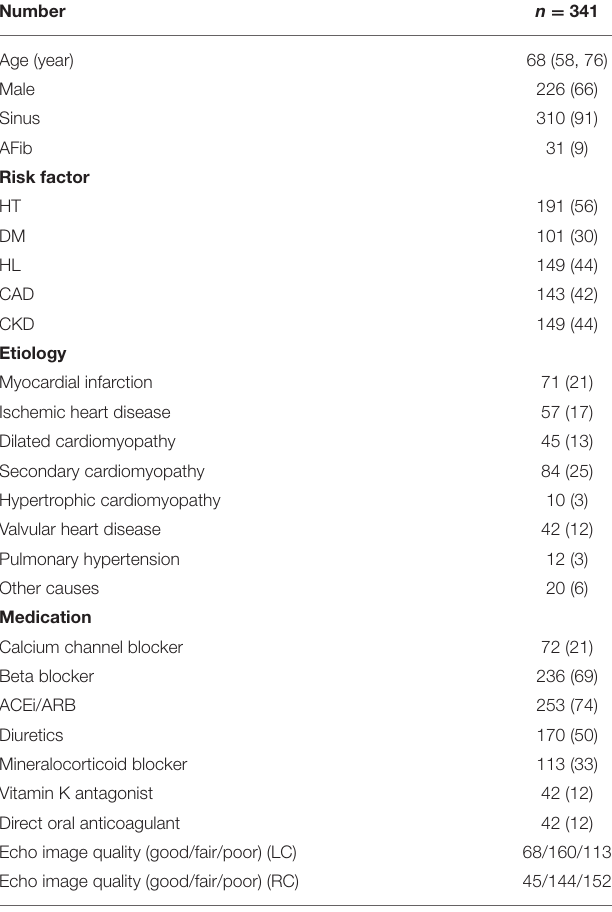
TABLE 1 | Clinical characteristics in the study